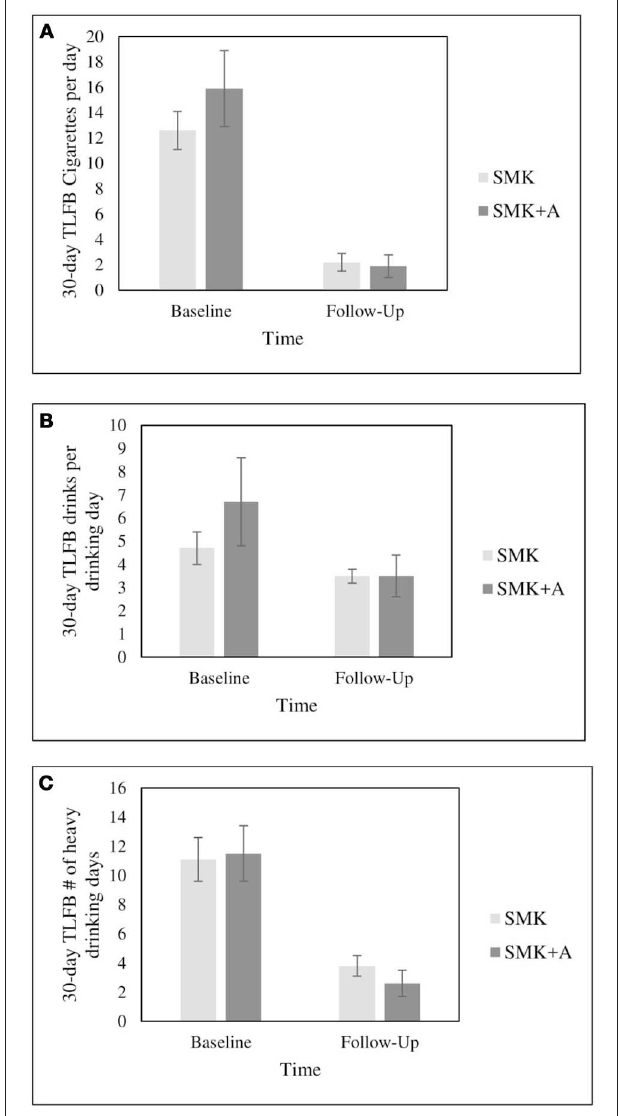
FIGURE 2 | Comparisons over time of 30-day TLFB cigarettes per day (A) , drinks per drinking day (B) , and heavy drinking days (C) . Error bars indicate standard